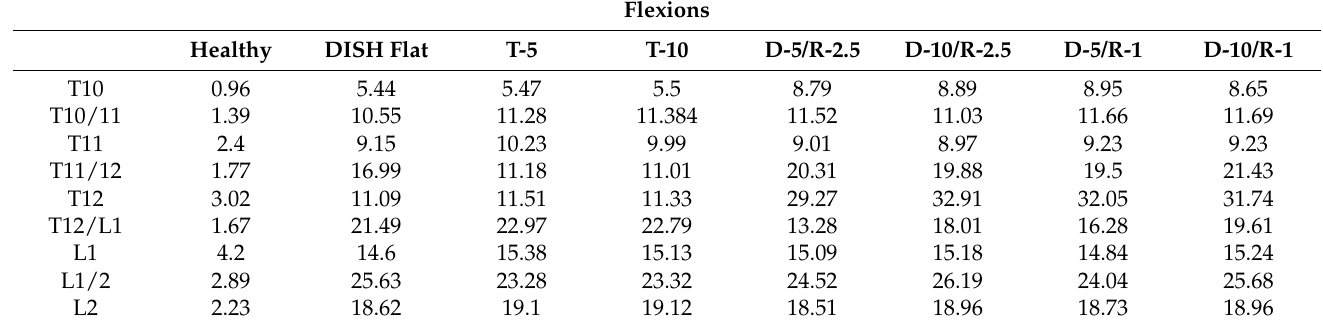
Figure 10. The highest value for maximum von Mises stress on the vertebral body and intervertebral disc (MPa) in flexion. The vertical axis is stress (MPa), and the horizontal axis is each vertebral body and intervertebral level. Table 4. The highest value for maximum von Mises stress on the vertebral body and intervertebral disc (MPa). Flexions Healthy DISH Flat